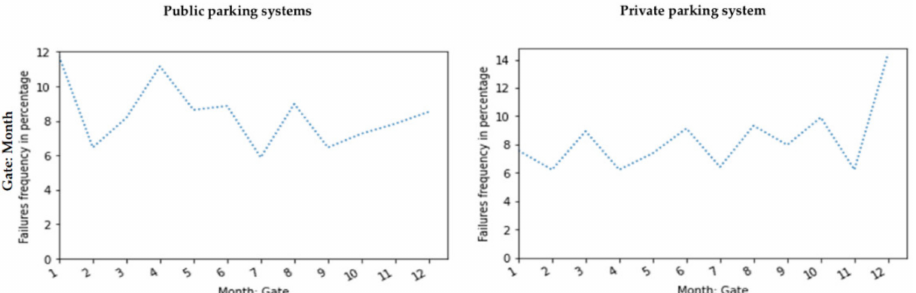
Figure 15. The month of the year for all gate failure events in public ( left ) and private ( right ) parking systems.